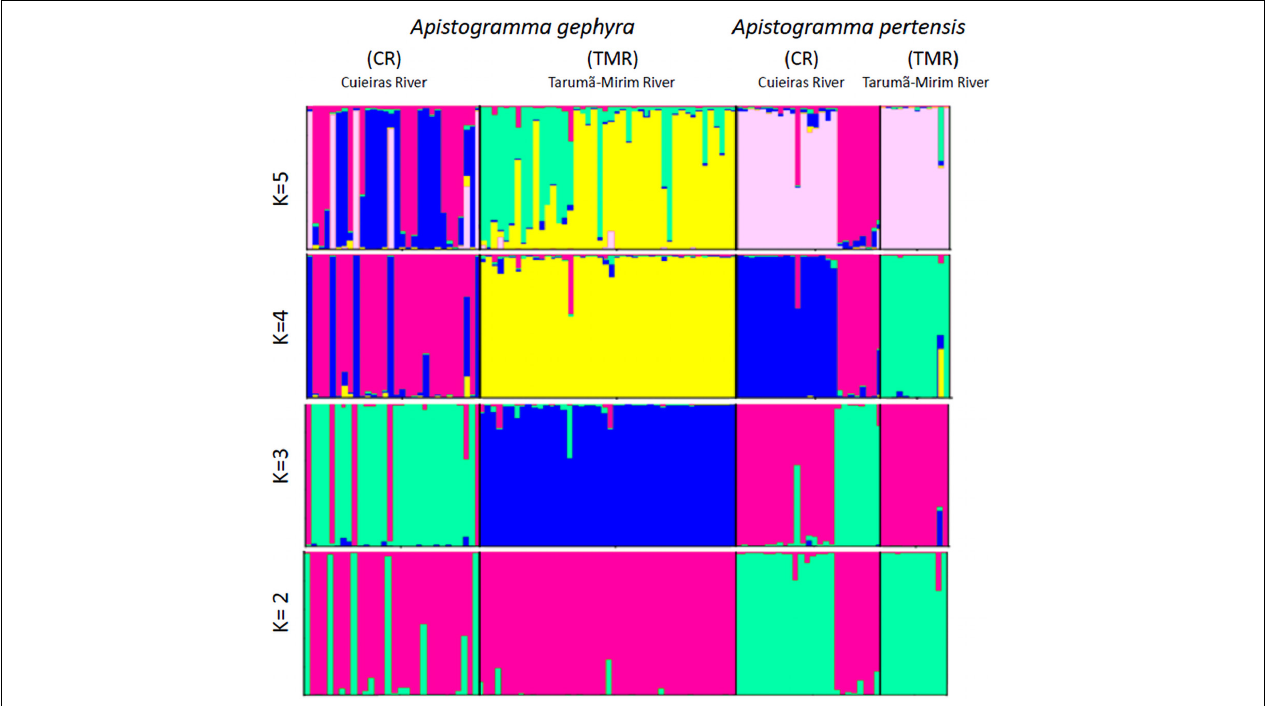
FIGURE 2 | Structure analysis. Graphs obtained using STRUCTURE software. Analysis of all the populations for both species (a) based on 11 microsatellite loci shows K = 5.